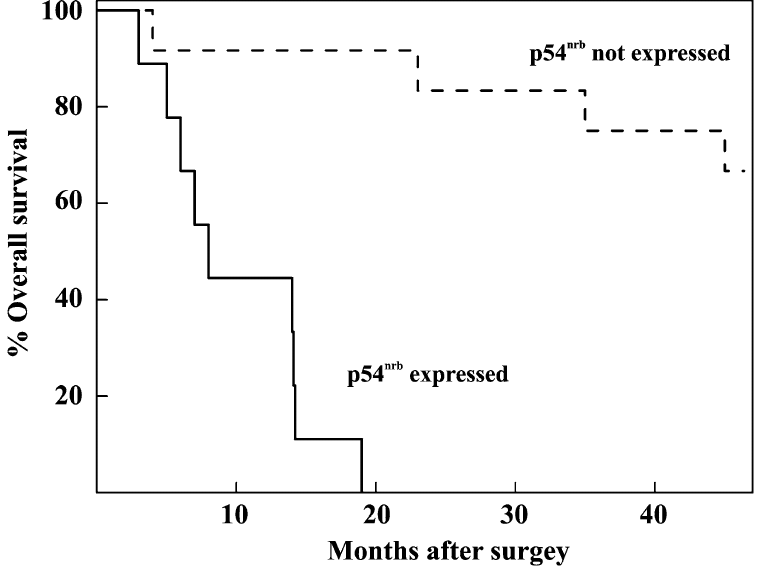
Fig. 3. Kaplan–Meier curves for overall survival according to p54 nrb expression in the whole group of patients ( n = 21) with muscle invasive TCC ( P < 0 .